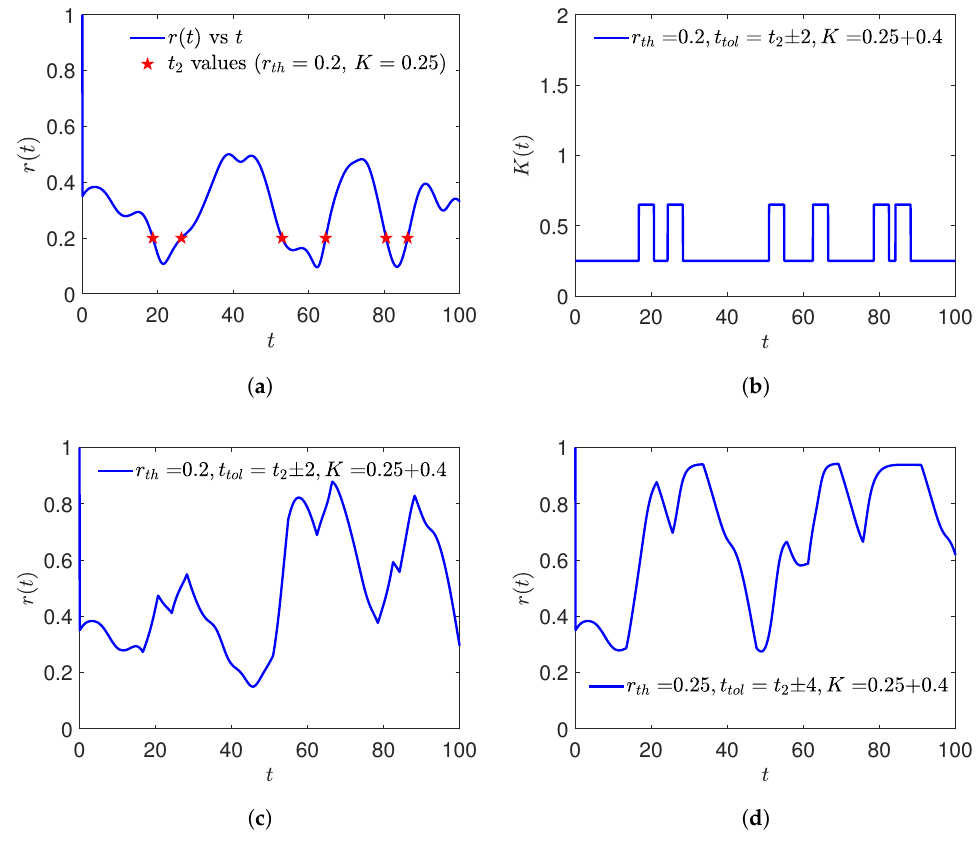
Figure 5. ( a ): Estimating the t 2 values at r = r th for a 32 oscillator system. These points lack periodicity and are located at random distances in the r ( t ) vs. t curve. ( b ): K vs. t graph for 32 oscillator system after giving K add in the vicinity of r = r th = 0.2. The higher value of K is applied in a narrow interval, causing no noticeable increase in the K ave . ( c ): Respective r ( t ) vs. t graph for a 32 oscillator system after giving K add in the vicinity of r = r th = 0.2. Finally, the higher tolerance value ± 4 is used in ( d ) of r ( t ) vs. t graphs. Now, every point in the graph lies above the r th due to the increased value of